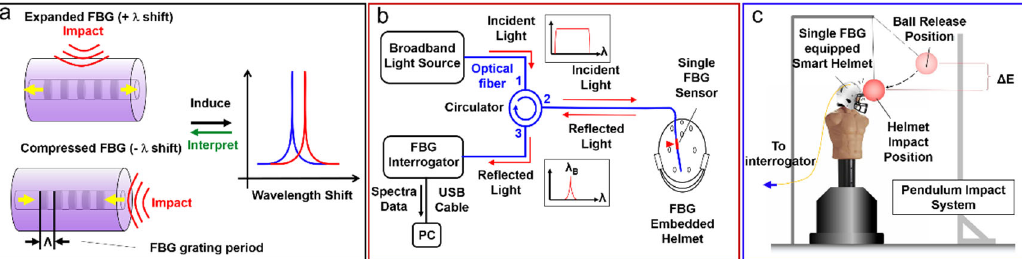
Figure 1. Schematics of the FBG sensors ( a ), the pendulum impact system ( b ) and the light pathway, as well as the signal interrogation method ( c ) used in this study.